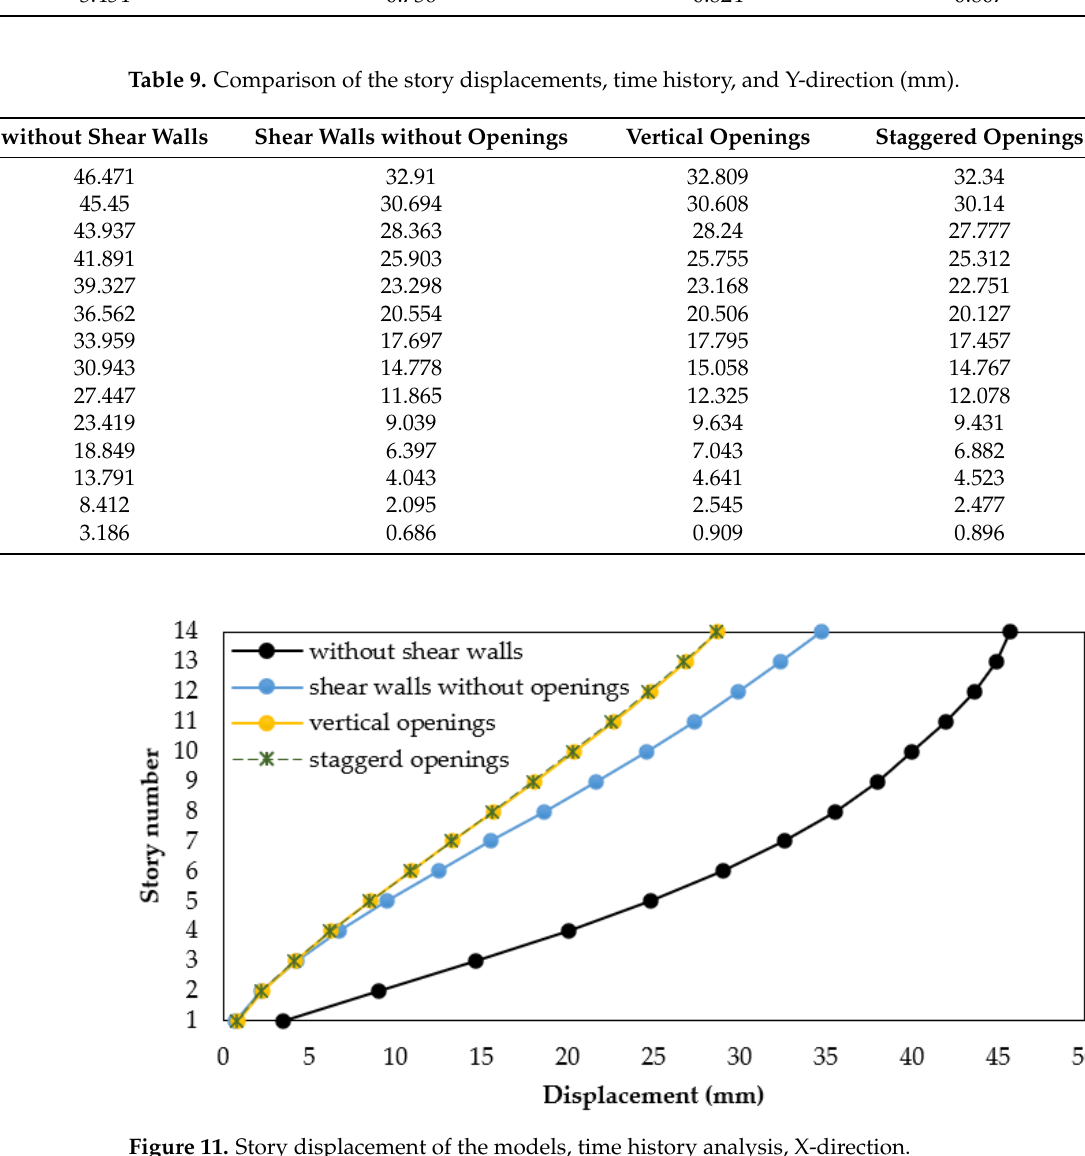
Figure 12. Displacement of the models, time history analysis, Y-direction.